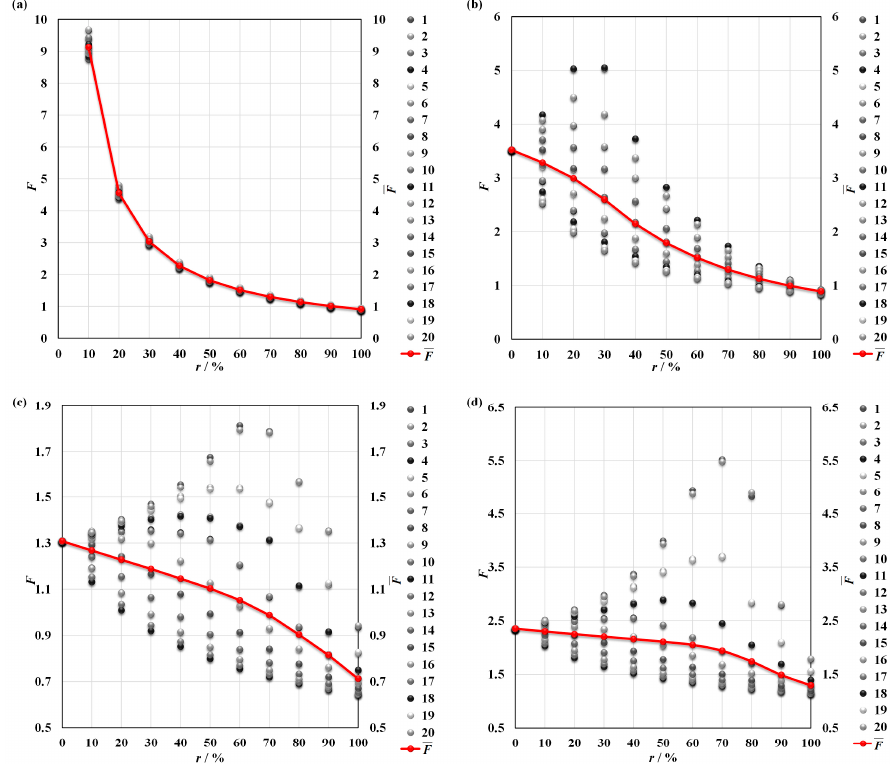
Figure 12. Evolution of safety factor: ( a ) case 1, ( b ) case 2, ( c ) case 3, ( d ) case 4.